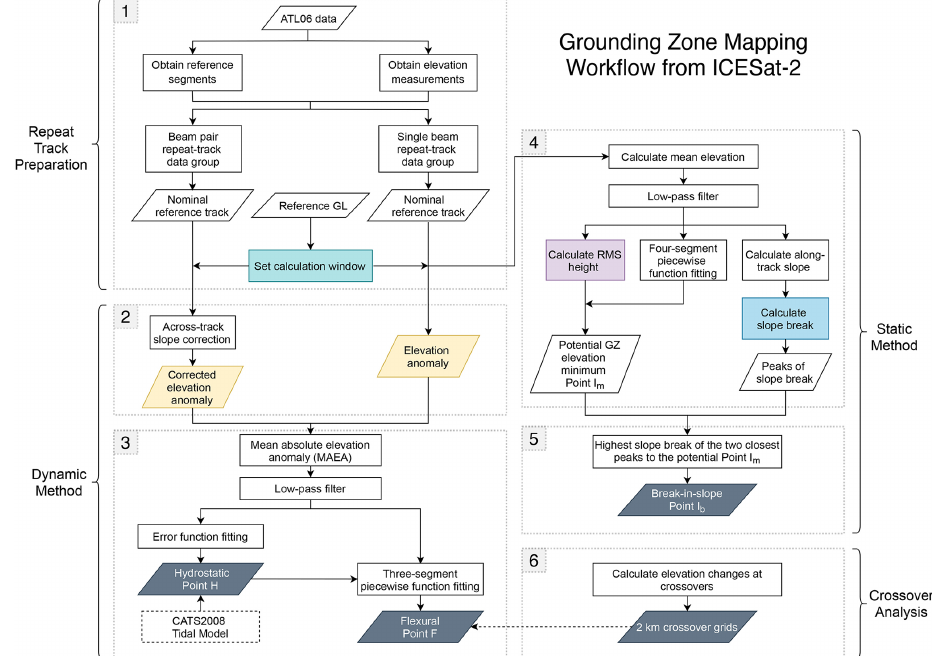
Figure 2. The automatic workflow of identifying the grounding zone (GZ) features from ICESat-2 data. Box 1: ICESat-2 repeat-track preparation; Boxes 2 and 3: estimation of the landward limit of tidal flexure (Point F) and the inshore limit of hydrostatic equilibrium (Point H) from the dynamic method; Boxes 4 and 5: estimation of the break in slope Point I b from the static method; Box 6: ICESat-2 crossover analysis. Grey parallelograms denote the grounding zone features. Boxes with other colours denote key steps in the GZ